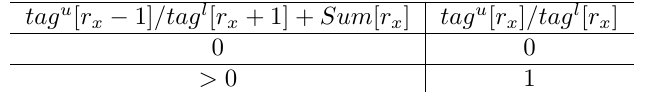
( UDDT [ r x ][ i ] 0 ≤ i ≤ n − 1